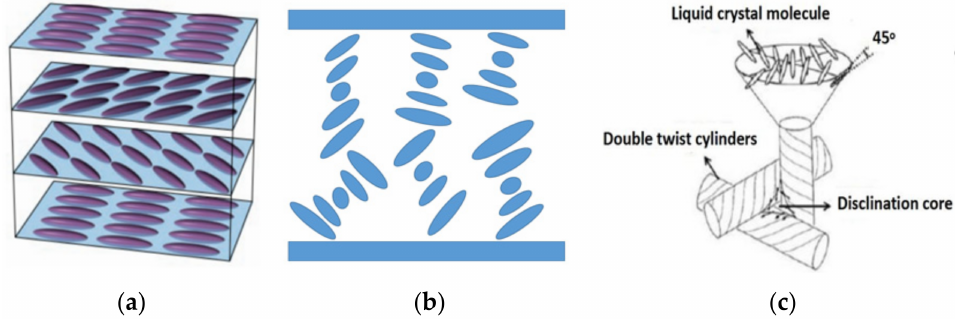
Figure 1. The arrangements of LC molecules in ( a ) planar texture state CLC; ( b ) focal conic CLC; ( c ) BPLC.